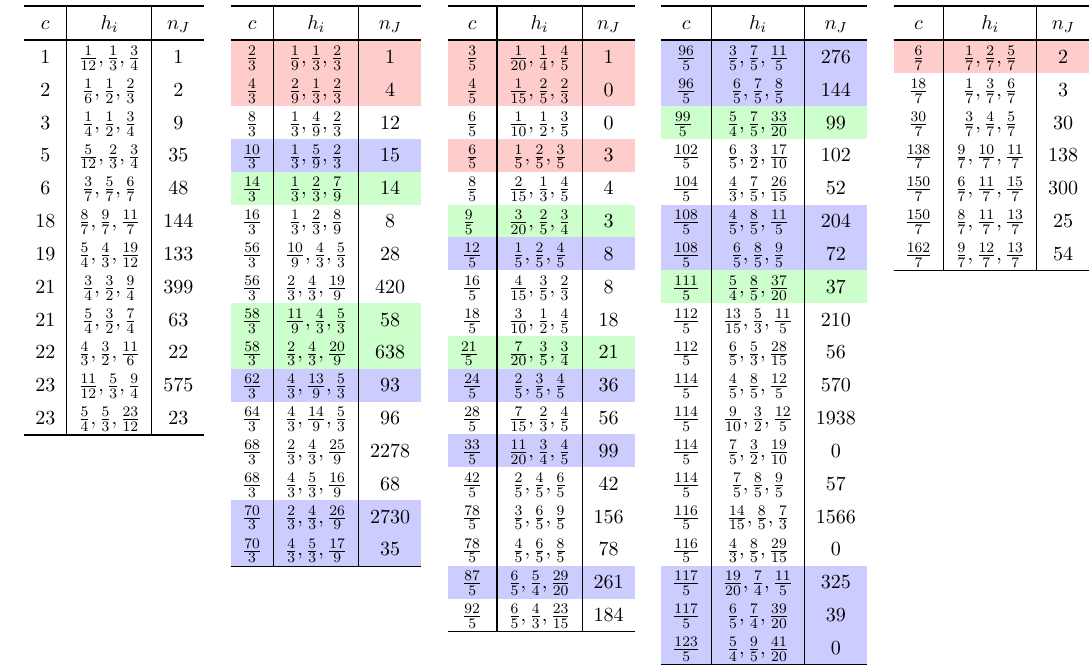
Table 6 . List of all potential ( d, ‘ ) = (4 , 0) theories. Rows colored red denote theories which admit multiple vacuum interpretations. Here we have chosen a single possible interpretation, and n the number of spin-1 currents in that interpretation. Rows colored green (blue) denote cases with a positive (negative) integer Verlinde